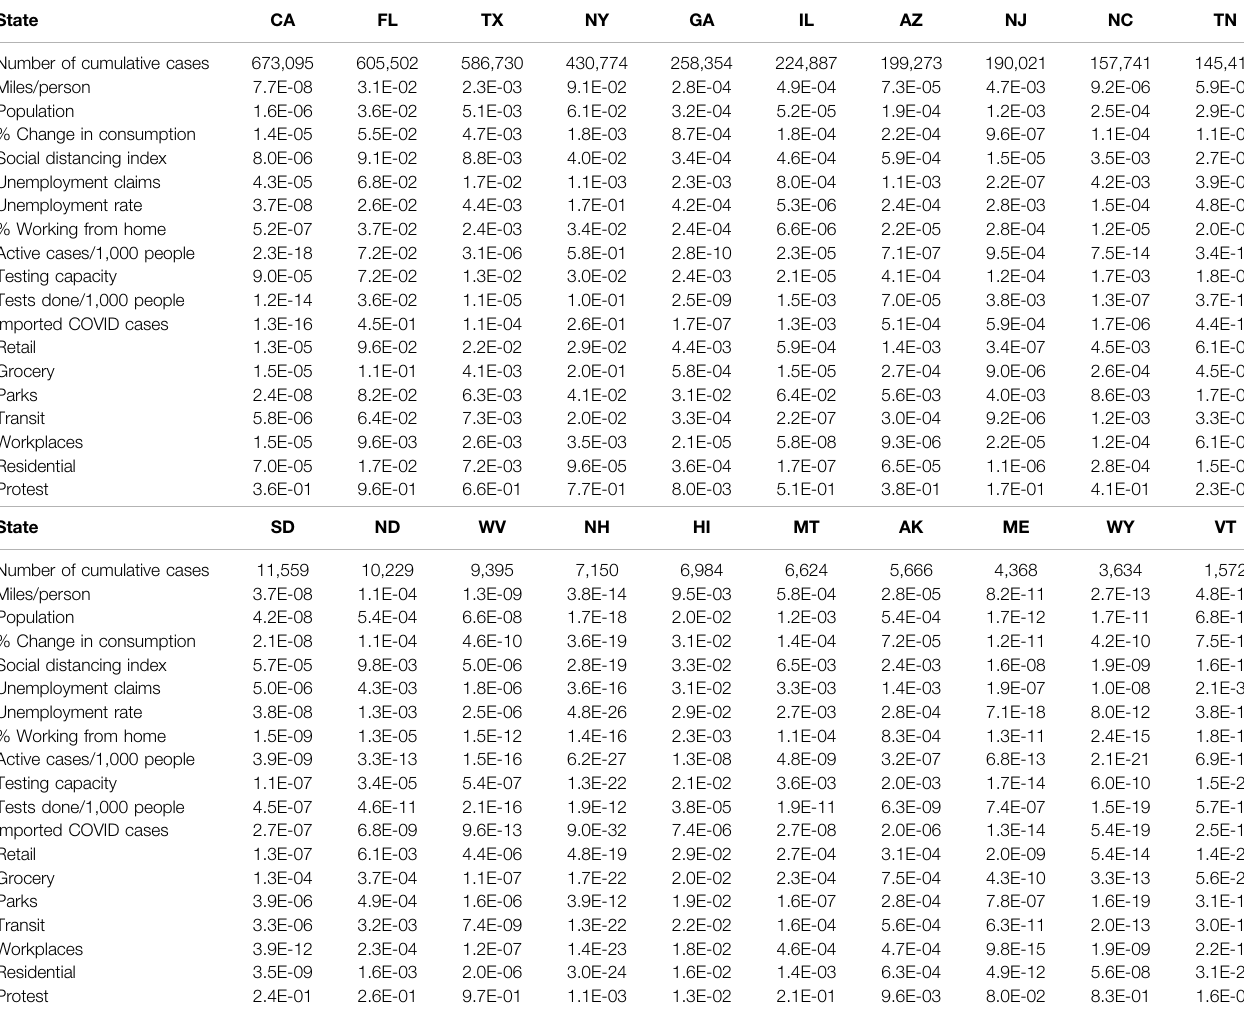
TABLE 2 | p -values testing 18 temporal potential causes of the number of new cases of COVID-19 in the top 10 most affected states and bottom 10 less affected states in the US. State CA